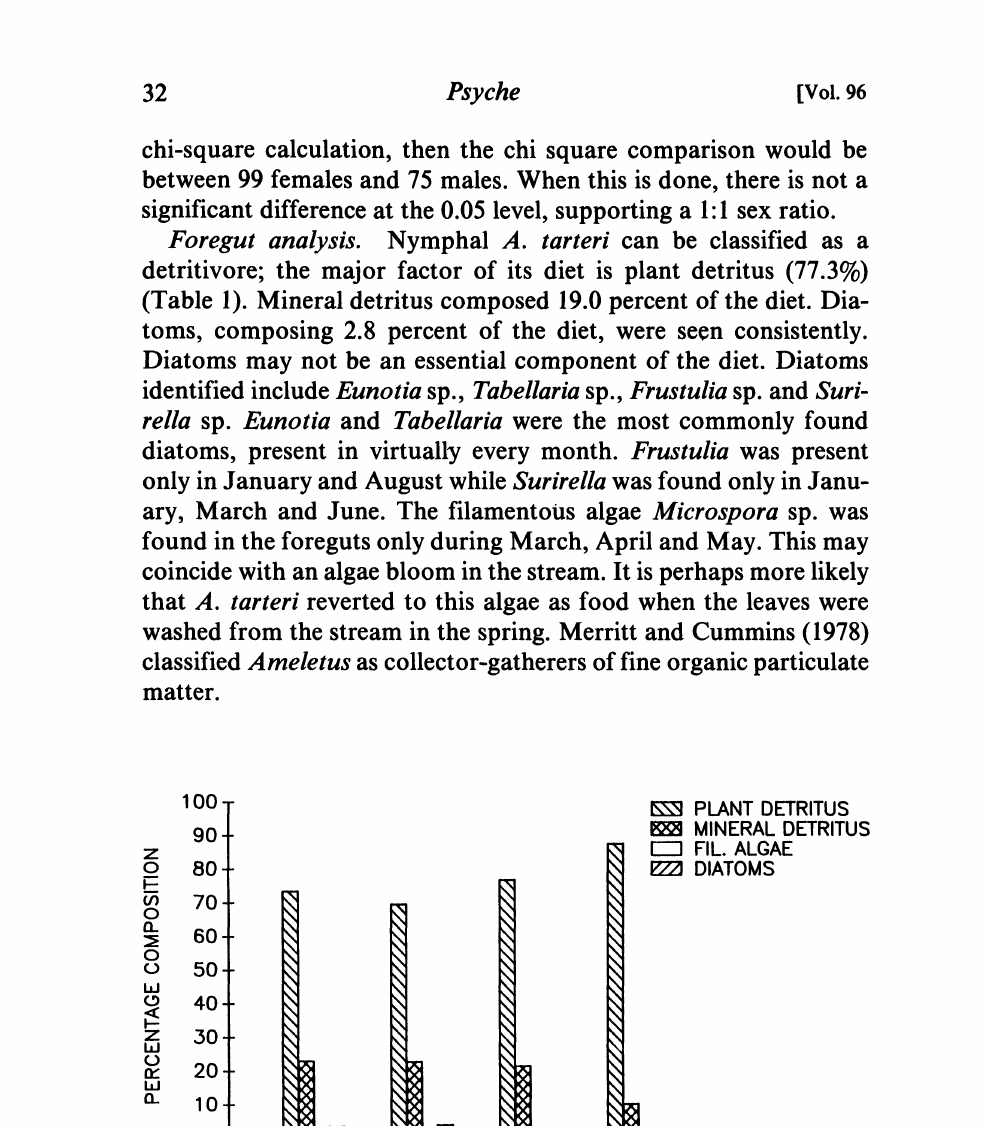
Figure 6. Seasonal foregut content of nymphal Ameletus tarteri from Carpenter Run, December 1986 to November